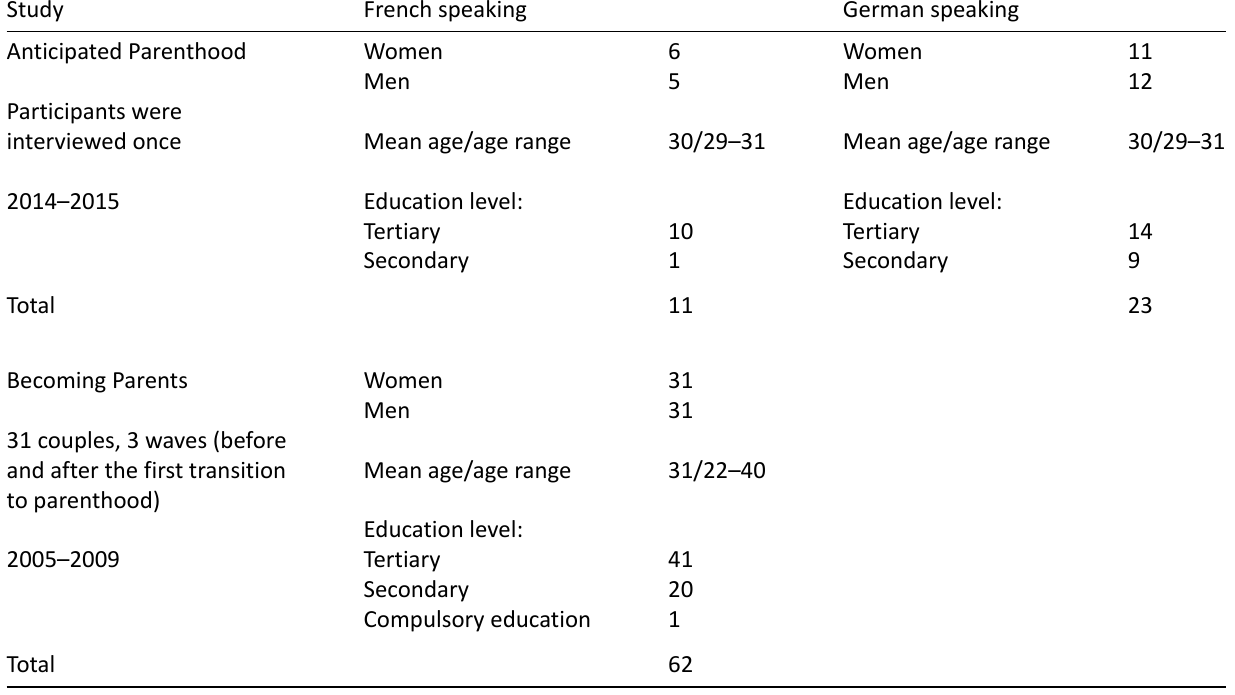
Table 1. Overview of the